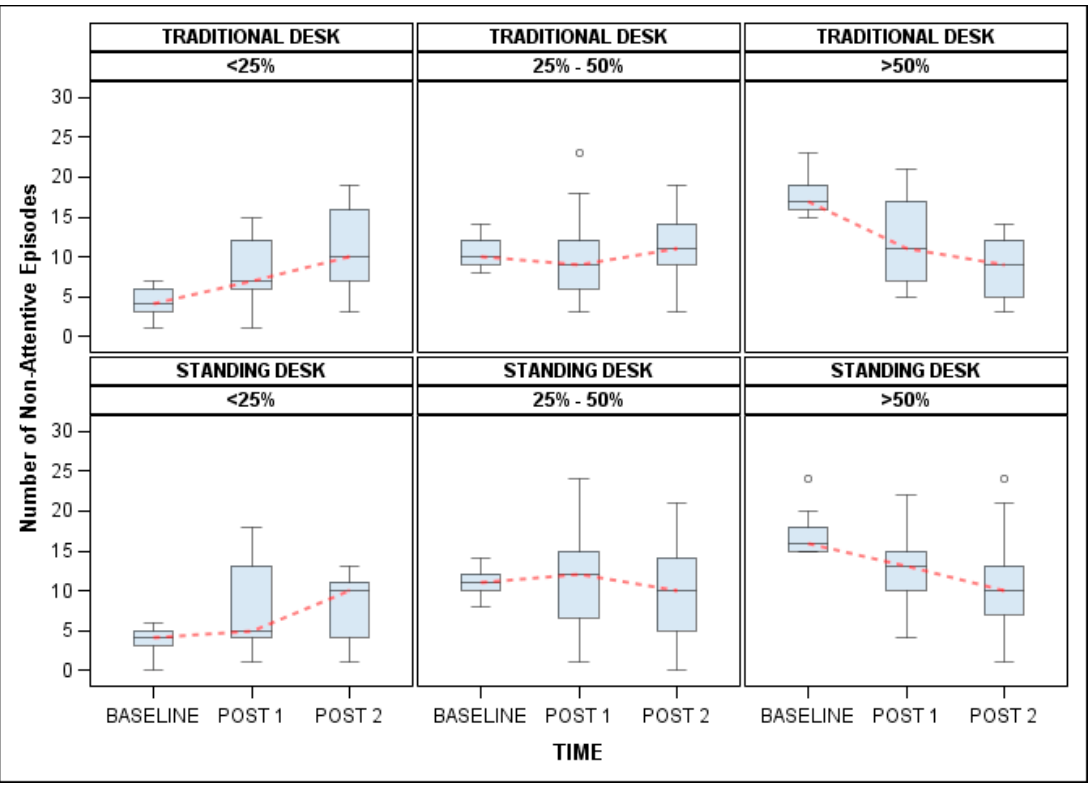
Figure 3. Illustration of the number of non-attentive episodes across time separated by the group assignment and baseline fidgeting behavior.